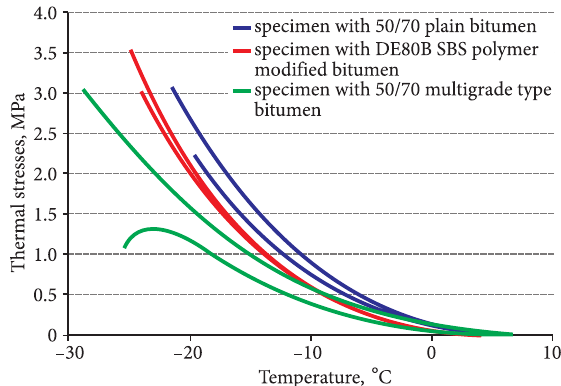
Fig. 2. Thermal stresses vs. temperature in TSRST testing of asphalt concrete specimens containing three bitumen types